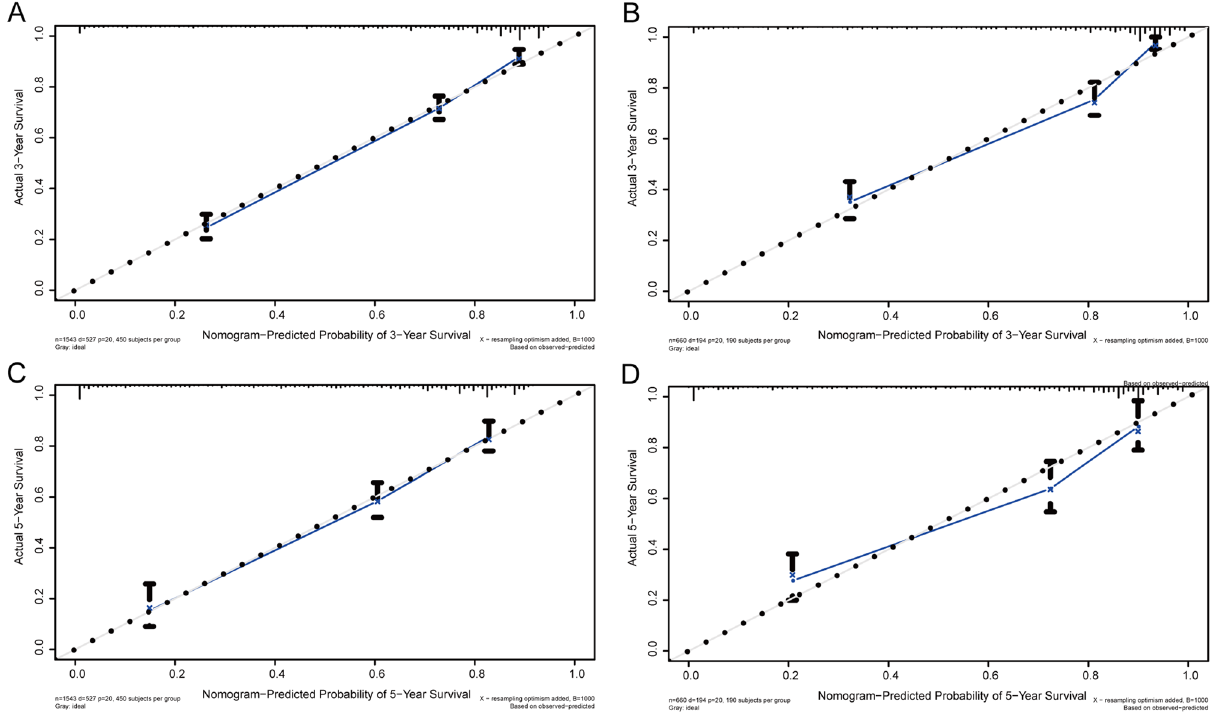
Figure 6. The calibration curve to evaluate the 3-year ( A ) and 5-year ( B ) survival for second primary malignancy (SPM) patients in training set; The calibration curve to evaluate the 3-year ( C ) and 5-year ( D ) survival for SPMs patients in the validation set. Nomogram-predicted overall survival (OS) is plotted on the x-axis; actual OS is plotted on the y-axis. The imaginary line indicates a perfect calibration model in which the predicted probabilities are identical to the actual survival